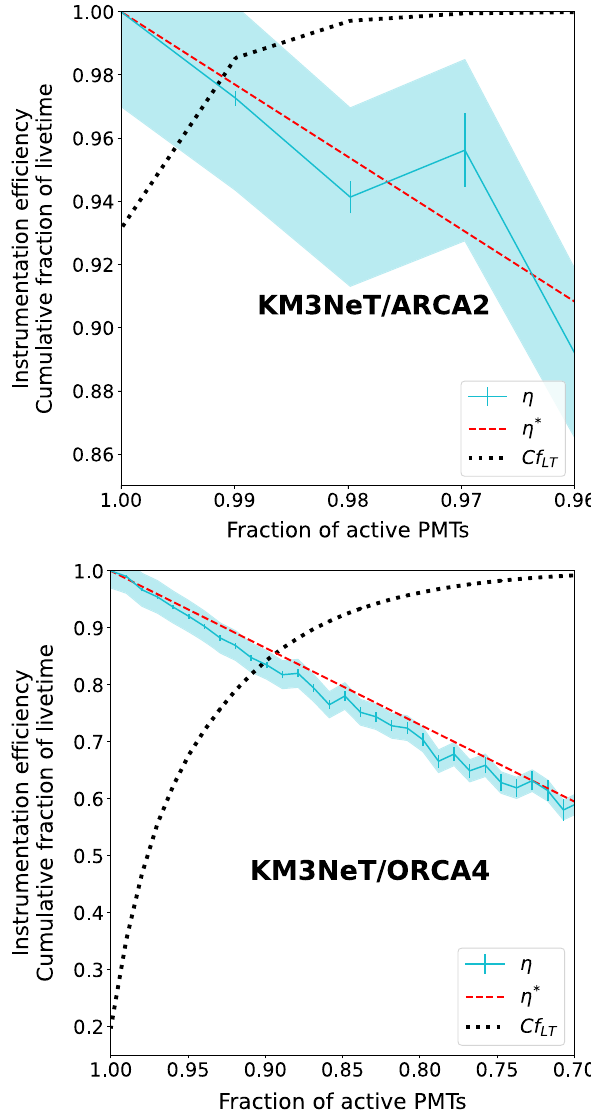
Fig. 2 Measured instrumentation efficiency, η , as a function of the fraction of active PMTs in the ARCA2 (top) and ORCA4 (bottom) detectors. Statistical errors are shown as error bars. Monthly variability iscoveredbytheshadedarea.Theparameterisation, η ∗ ,adoptedtoscale the background expectation in the trigger is drawn as a red dashed line. The cumulative fraction of livetime, C f LT , representing the fraction of livetime for which the detector has more than a given fraction of active PMTs, is superimposed as a black dotted line